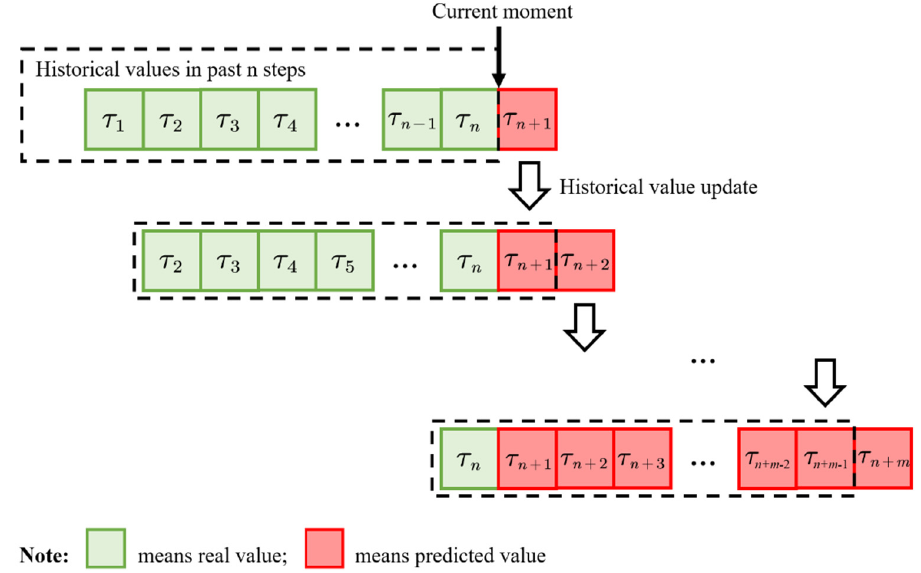
Figure 4. Schematic of multi-step prediction (7-step, n = m = 7; satisfy the weekly report requirement of food supervision department).